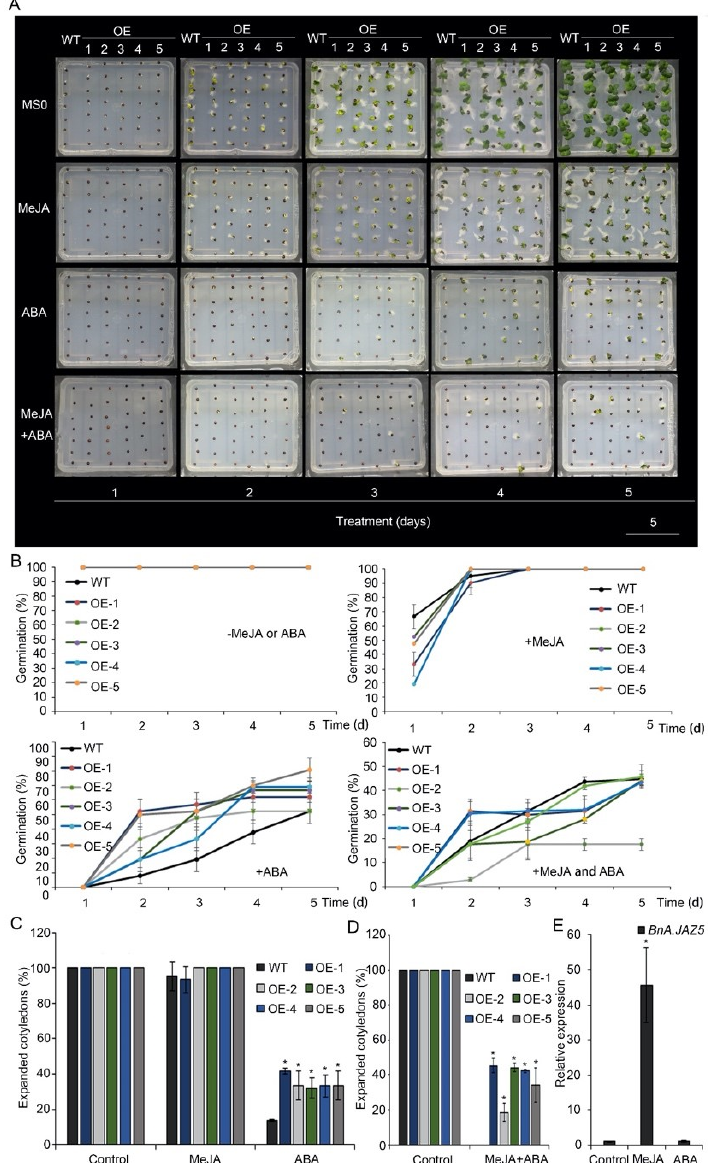
Figure 5. Seed germination of p35S::BnA.JAZ5 plants on MS medium supplemented with 50 µ M MeJA, 9 µ M ABA or both 50 µ M MeJA and 9 µ M ABA, respectively. ( A ) Phenotypes of seed germination of five overexpressing lines under 50 µ M MeJA, 9 µ M ABA or both 50 µ M MeJA and 9 µ M ABA treatments. ( B ) Seed germination rate of five overexpressing lines under 50 µ M MeJA, 9 µ M ABA or both 50 µ M MeJA and 9 µ M ABA treatments. ( C ) The percentage of wild-type and p35S::BnA.JAZ5 rapeseed seedlings with expanded cotyledons was scored 4 d after stratification on MS medium supplemented with 50 µ M MeJA or 9 µ M ABA. ( D ) The percentage of wild-type and p35S::BnA.JAZ5 rapeseed seedlings with expanded cotyledons was scored 9 d after stratification on MS medium supplemented with both 50 µ M MeJA and 9 µ M ABA. ( E ) Expression levels of BnA.JAZ5 under 50 µ M MeJA or 9 µ M ABA treatments. Error bars represent standard errors. Asterisks indicate significant differences between wild-type and p35S::BnA.JAZ5 lines ( p < 0.05). WT, accession K407. OE-1, OE-2, OE-3, OE-4 and OE-5, p35S::BnA.JAZ5 lines. Scale bar, 5